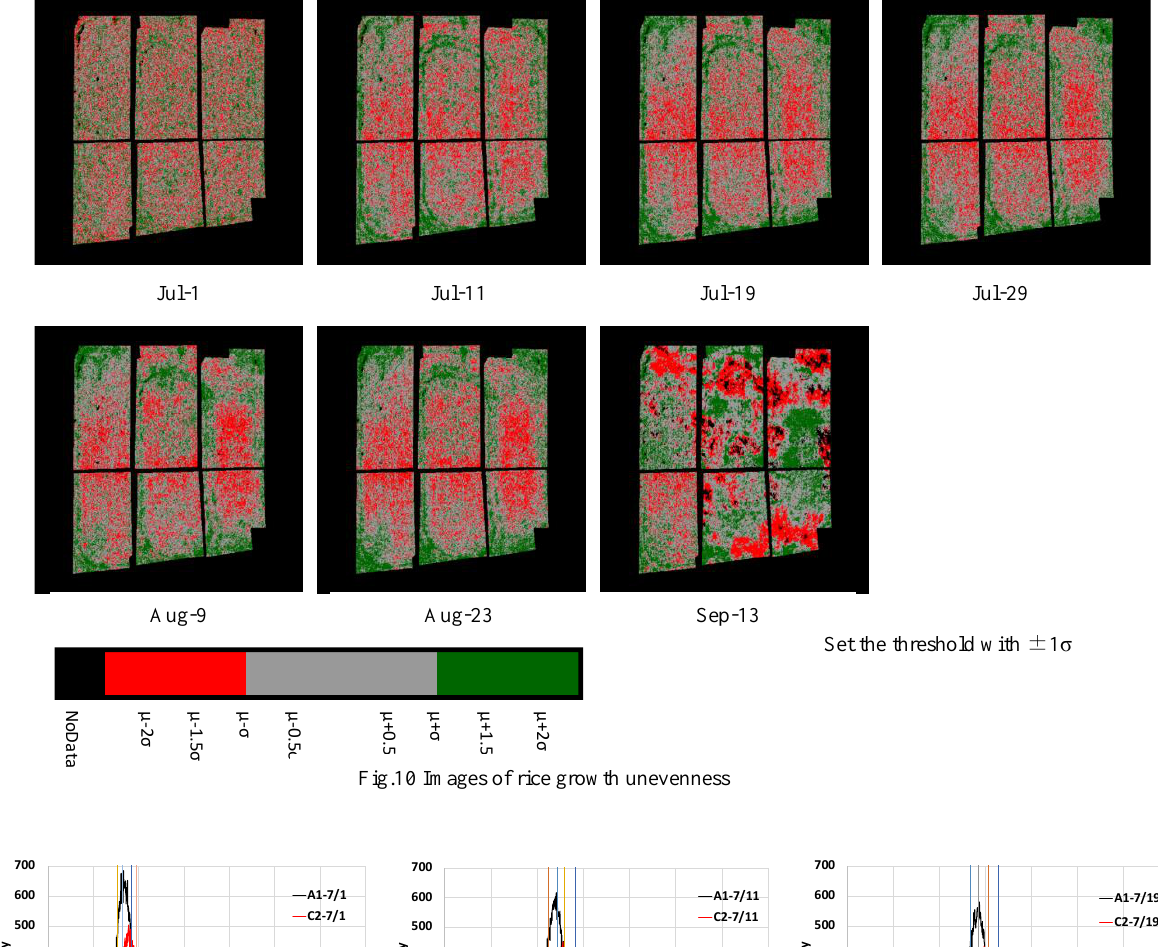
Fig.10 Images of rice growth unevenness